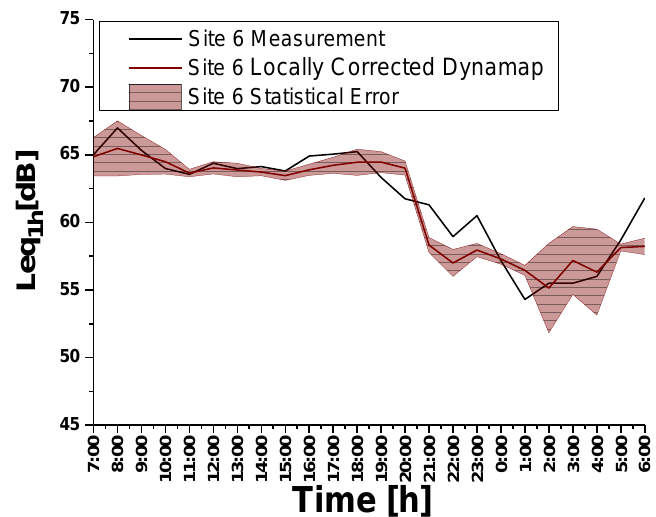
Figure 17. Comp arison between traffic noise measurement and the “locally corrected” DYNAMAP Figure 17. Comparison between tra ffi c noise measurement and the “locally corrected” DYNAMAP prediction for Site 6. prediction for Site 6.